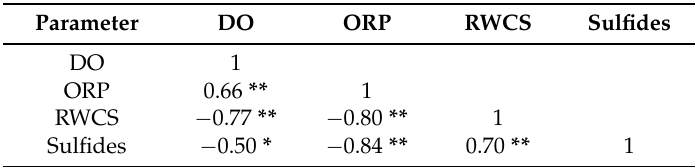
Table 1. Pearson correlation ( r -value) matrix for water quality parameters. Parameter DO ORP RWCS Sulfides DO 1 ORP 0.66 ** 1 RWCS ´ 0.77 ** ´ 0.80 ** 1 Sulfides ´ 0.50 * ´ 0.84 ** 0.70 **